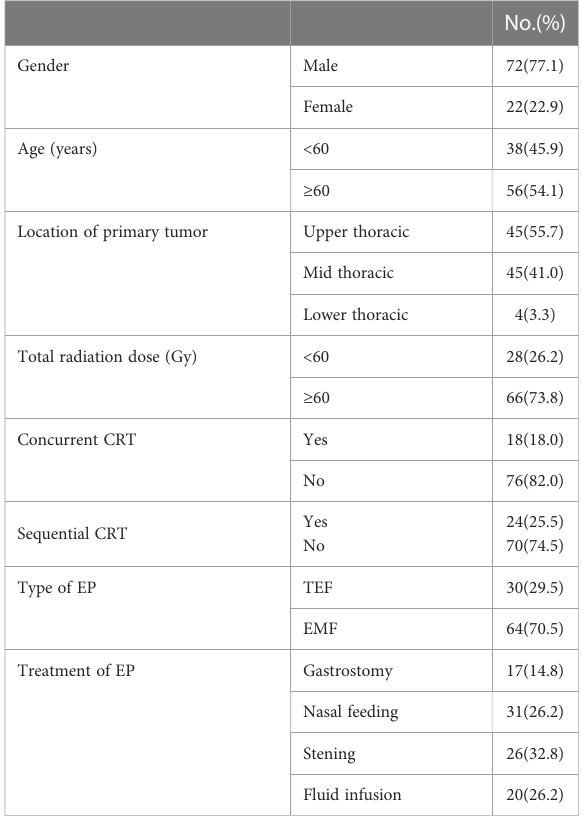
TABLE 1 Patients